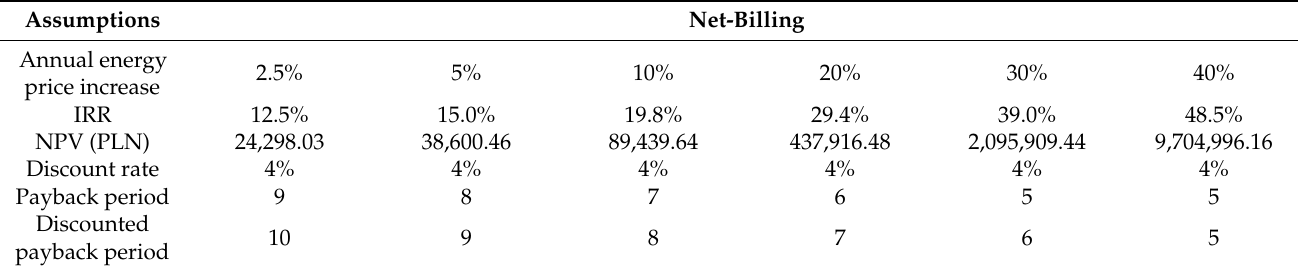
Table 3. Financial analysis results for